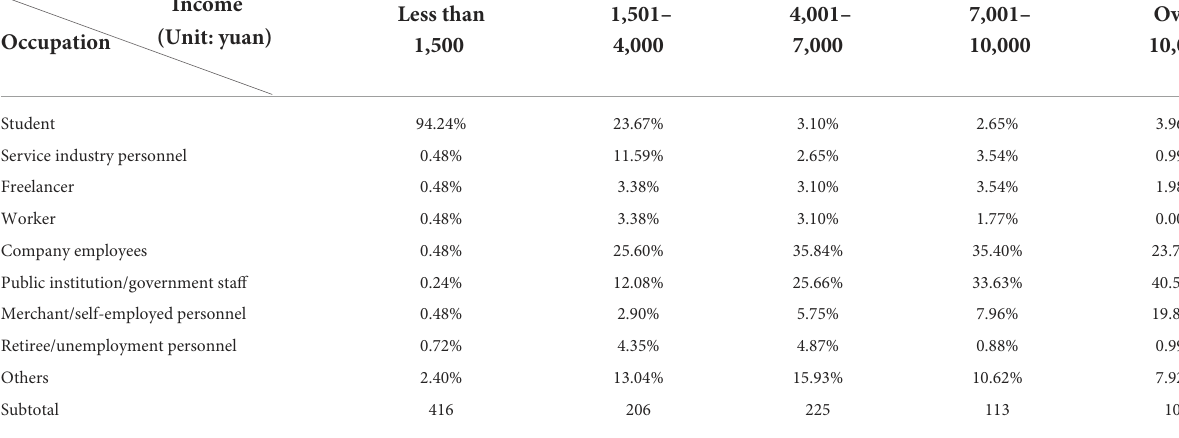
TABLE 9 Occupation-income cross-analysis for online food consumers.